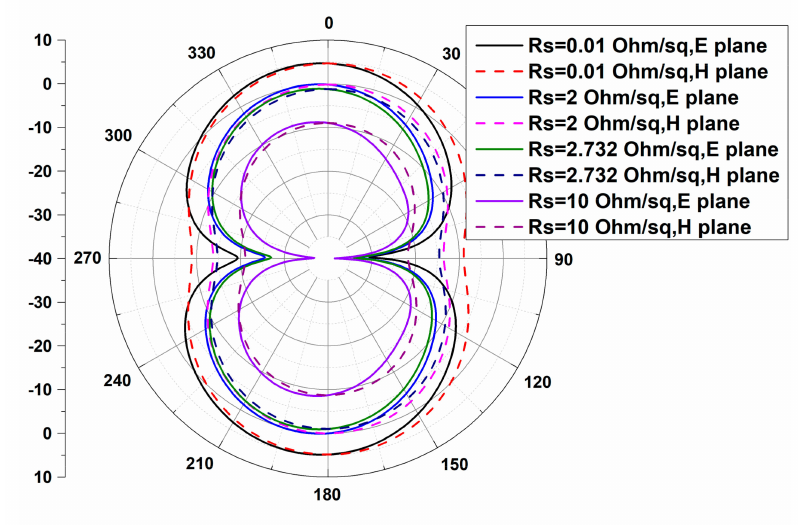
Figure 6. Sheet resistance of the ITO / copper composite film measured by a digital four-probe tester.